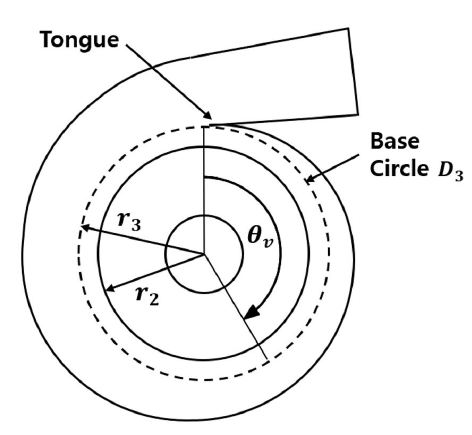
Figure 5. Volute